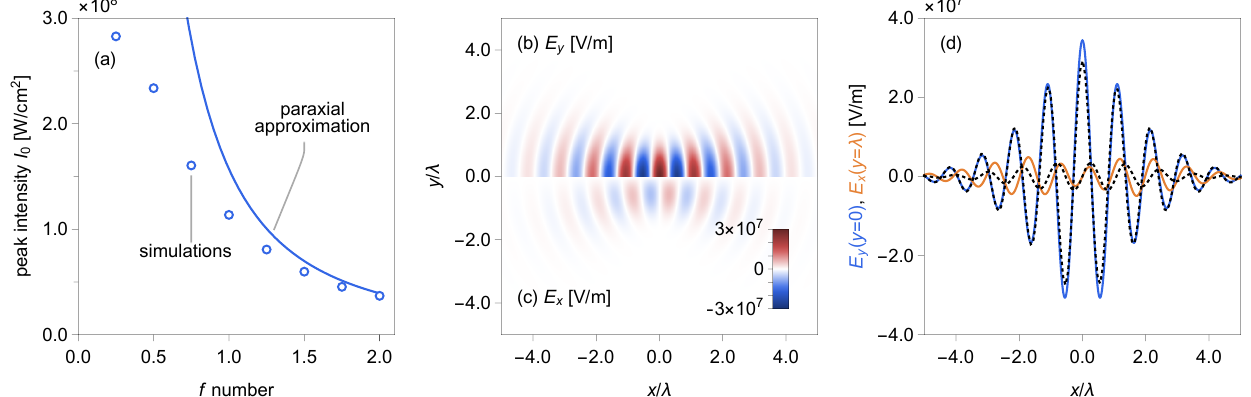
Figure 5. Comparison of numerical and analytical results for a tightly focused pulse with Gaussian temporal and angular profiles and fixed peak power P = 1 W: ( a ) The peak intensity at focus. The ( b ) transverse and ( c ) longitudinal fields in the plane z = 0, at focus, from simulations with an f -number of 1. ( d ) Comparison of theoretical (solid colors) and simulation (black, dashed) results for the transverse field along y = z = 0 (blue) and the longitudinal field along y = λ and z = 0, at focus, for f =